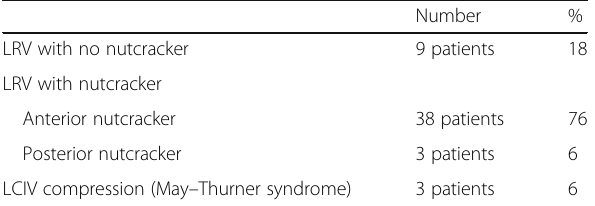
Table 3 Demonstrating the left renal vein (LRV) nutcracker status and the left common iliac vein (LCIV) compression in the study as well as the patients ’ number and